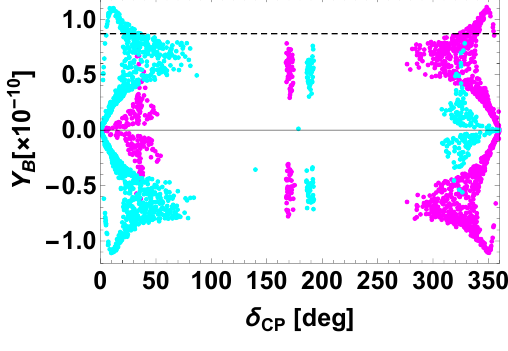
Figure 14 . Predictive Y B versus δ CP at M 1 = 3 . 36 × 10 13 GeV. Points correspond to the low energy output of section 4 at where cyan and magenta correspond to pos- itive and negative Re [ τ ] , respectively. Hori- zontal dashed line denotes the central value of observed Y B